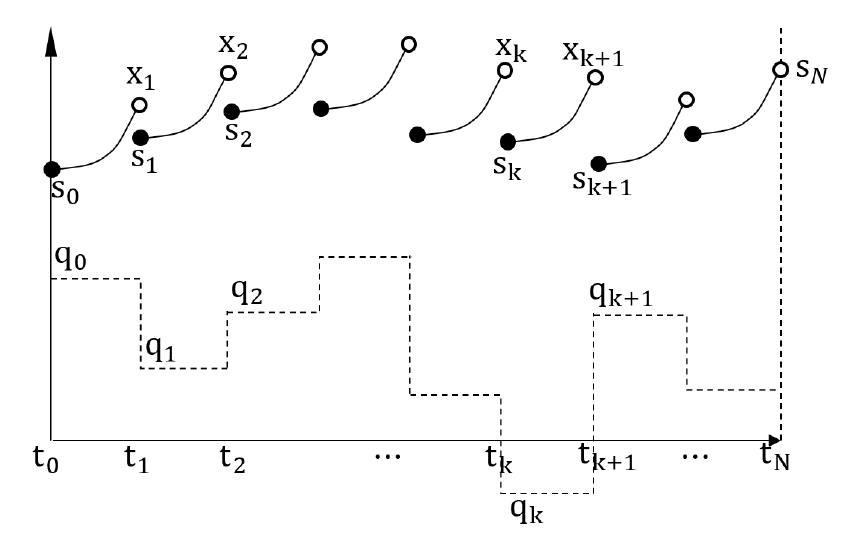
Figure 6. Illustration of direct multiple